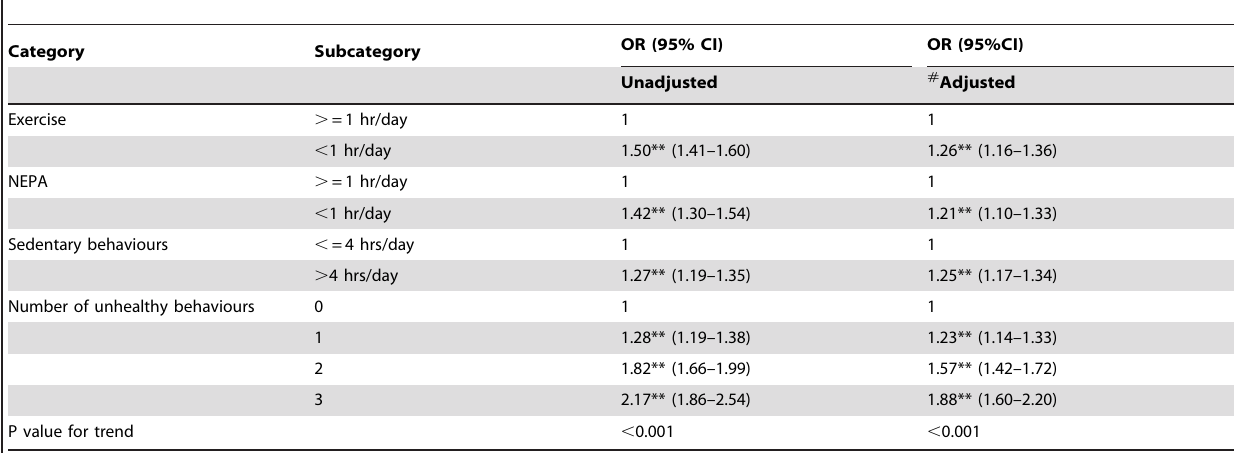
Table 2. Multivariate analyses of physical activity and sedentary behaviours and constipation.